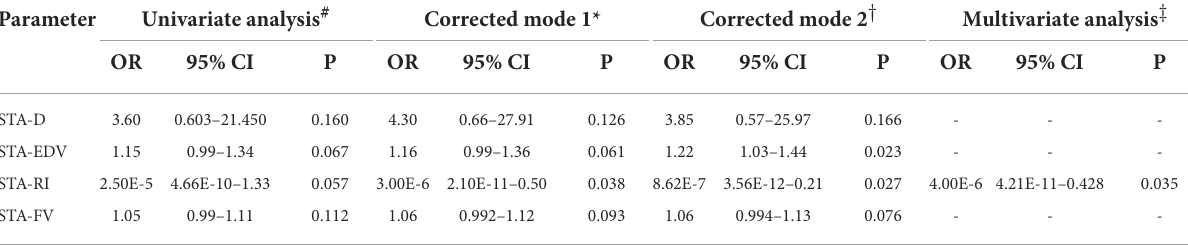
TABLE 8 The association of preoperative STA parameters with collateral development after revascularization surgery. Parameter Univariate analysis